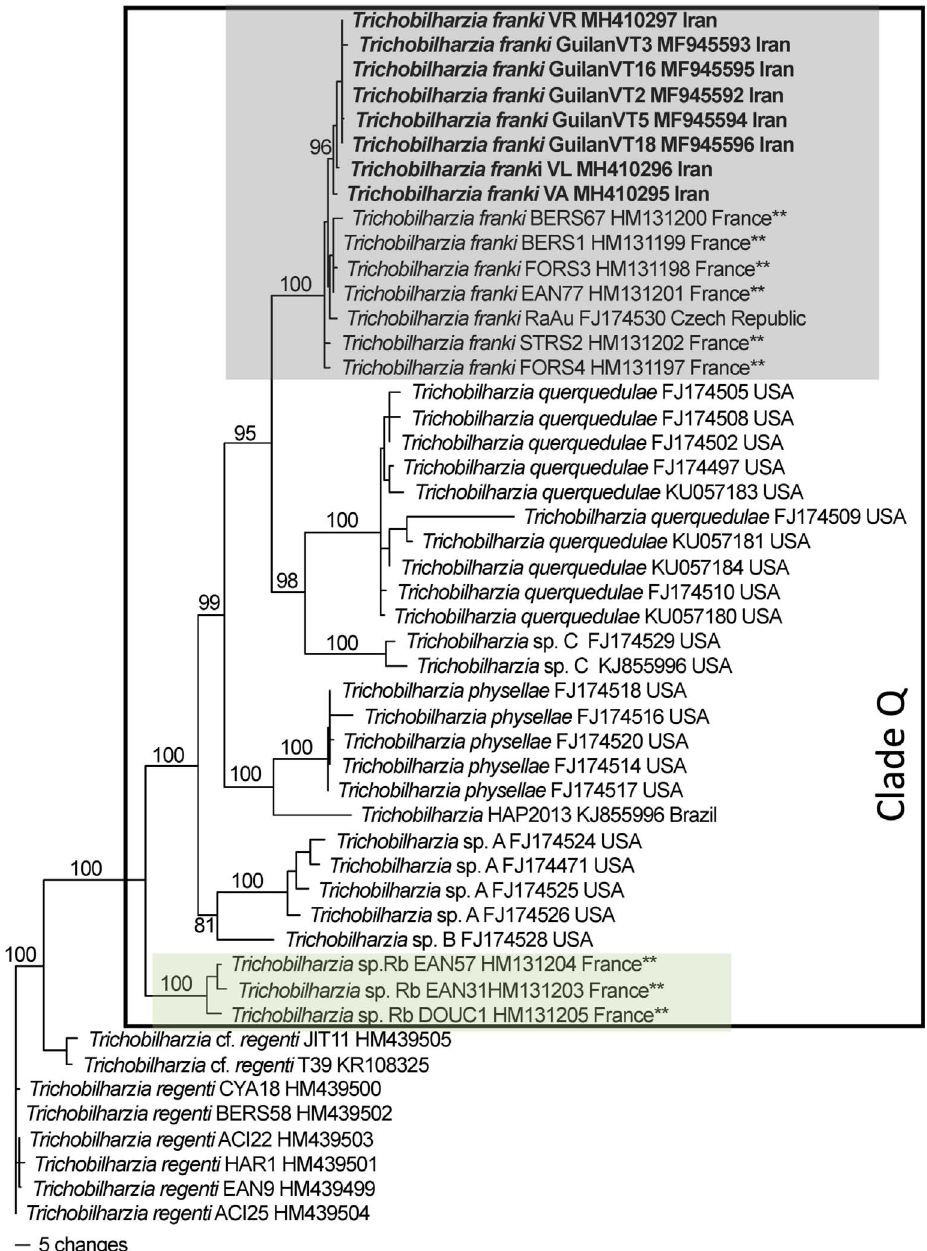
Figure 4. Phylogenetic tree based on Bayesian analysis of cox1 with nodal support indicated on the branches by posterior probabilities. The outer box de fi nes taxa in Clade Q sensu Brant and Loker [14]. The gray boxed clade includes individuals of Trichobilharzia franki with the samples from this study in bold, all other samples are from R. auricularia snails. The green box highlights the “ peregra ” group ( sensu [37]); these species are often confused for T. franki but mostly come from A. balthica . The double asterisk indicates that the snail host in the study was also characterized genetically. Blue arrows indicate schistosomes from R. auricularia but did not group within the clade for T. franki . Taxa are listed with their corresponding GenBank accession number, followed by the country of collections (see Table